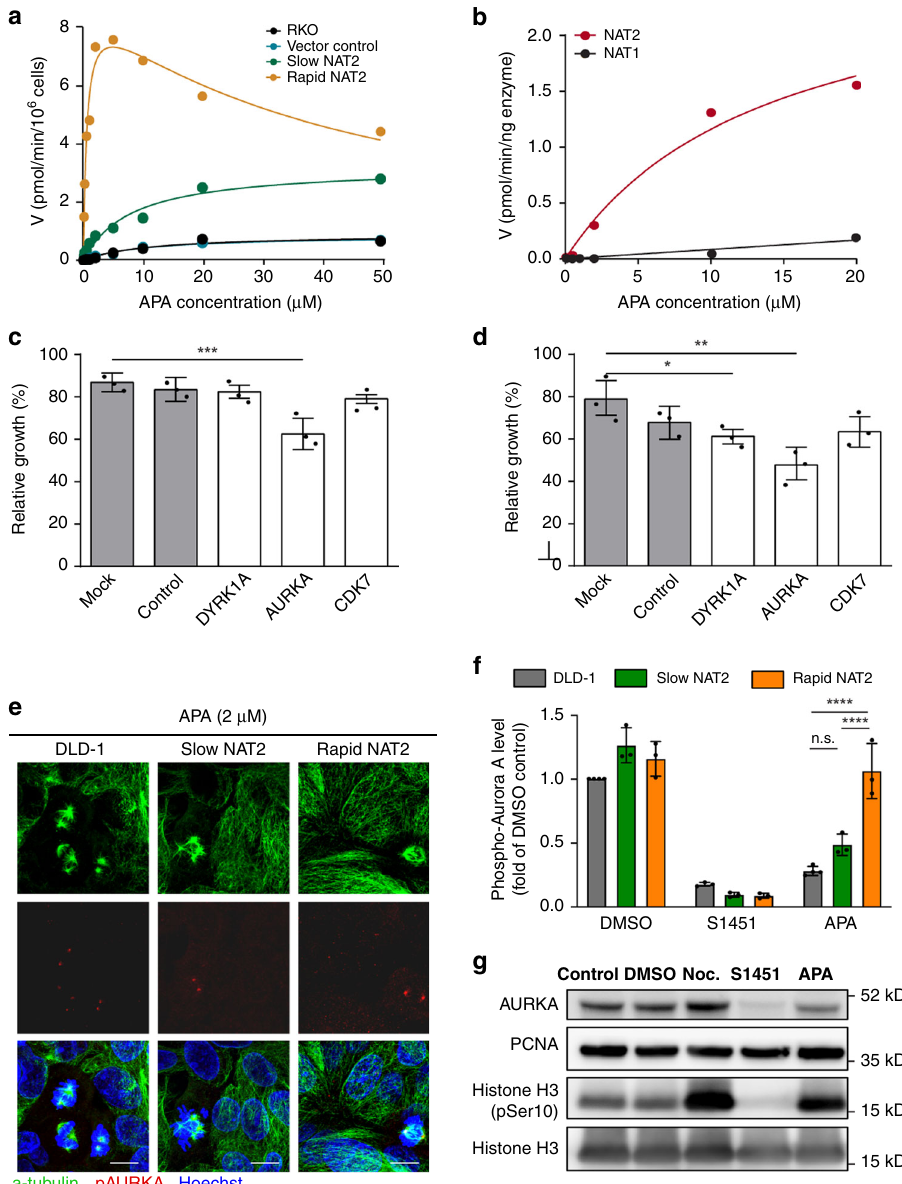
Fig. 3 The NAT2-speci fi c substrate APA causes mitotic arrest in slow NAT2 cells. a NAT2 mediates APA acetylation. The velocity of NAPA formation was determined by LC-MS/MS in slow (green), rapid (yellow) NAT2 clones, vector control (blue), and parental RKO cells (black) after incubation with APA at indicated concentrations. b APA is selectively metabolized by NAT2. Enzyme kinetics of NAPA formation by human recombinant NAT1 (black) and NAT2 (red) proteins. c , d siRNA-mediated gene silencing of protein kinases with differential inhibition by APA and NAPA expressed in RKO CRC cells. Relative growth of RKO ( c ) and DLD-1 ( d ) cells transfected with a pool of siRNA targeting DYRK1A , AURKA , CDK7 , non-target RNA control and mock transfection as percentage of the growth of untransfected cells. Mean and S.D. (error bars) of three independent experiments is shown. Data were analyzed by one-way ANOVA. * P = 0.0435, ** P = 0.0013, *** P = 0.0004. e APA (2 µ M) reduces the phospho-Thr288 Aurora kinase A (pAURKA) staining in NAT2-de fi cient cells but not in rapid NAT2 clones. Mitotic spindles were visualized by α -tubulin staining (green) and pAURKA levels (red). Representative images of three independent repeats are shown for each cell type. Scale bar, 10 µ m. f Quanti fi cation of pAURKA signal in parental DLD-1 and slow and rapid NAT2 clones after APA treatment (2 µ M). The pAURKA levels are shown as a fold of the DMSO control group. Mean and S.D. (error bars) of three independent experiments. Data were analyzed using two-way ANOVA. n.s., P = 0.0619 and **** P < 0.0001. g APA (2 µ M), similarly to the AURKA selective inhibitor S1451 (10 µ M) reduces the total protein level of AURKA in contrast to nocodazole (100 ng mL − 1 ). DLD-1 cells in different treatments were subjected to immunoblot analysis with different antibodies for detection of total AURKA, PCNA (loading control), histone H3 pSer10, and total histone H3. Representative immunoblot from at least two independent experiments is